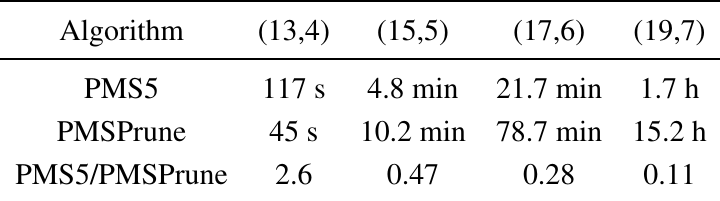
Table 3. Run times for PMS5 and PMSPrune [22].